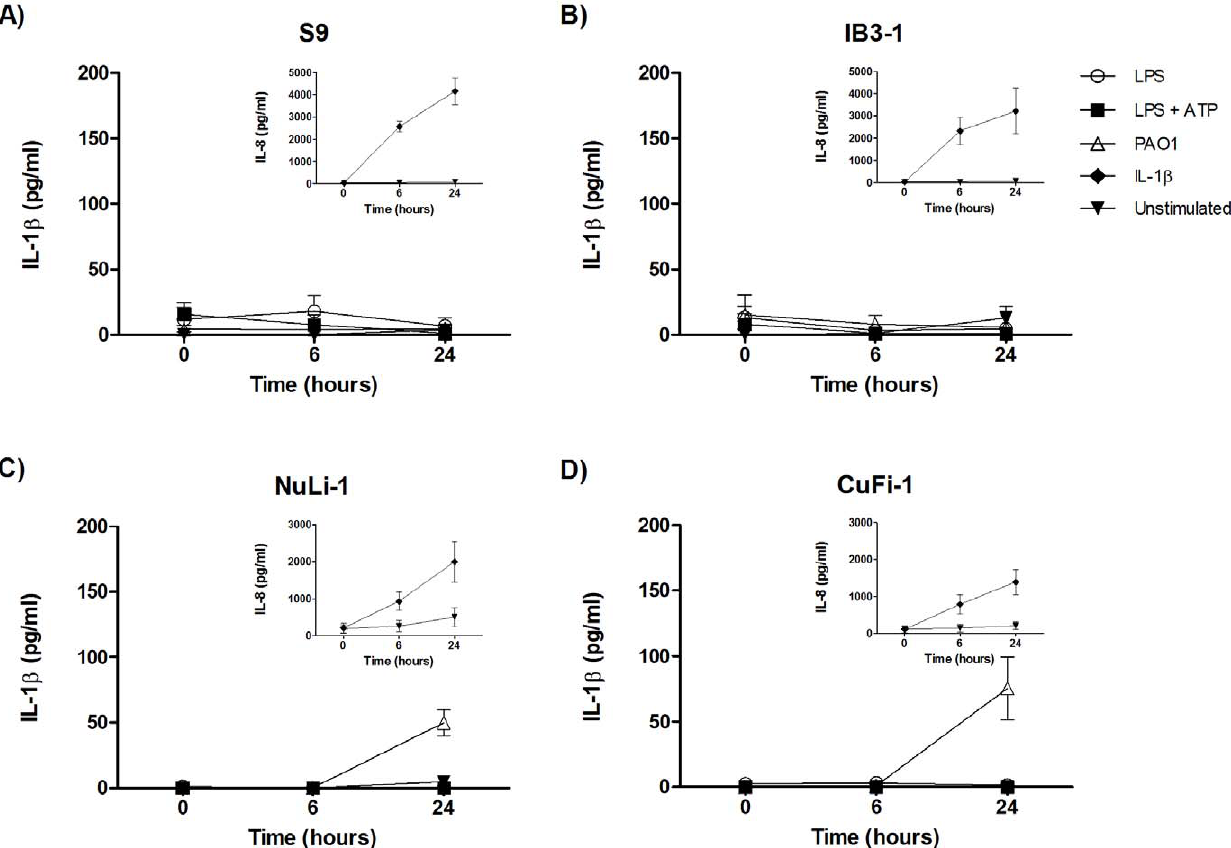
Figure 2. Airway epithelial cells do not significantly contribute to IL-1 b production in response to inflammasome stimuli. Control cell lines ((A) S9, (C) NuLi-1) and their corresponding CF cell lines ((B) IB3-1, and (D) CuFi-1) cells were stimulated with P. aeruginosa (MOI=10), ATP (5 mM), or IL-1 b (10 ng/ml), for the indicated times (n=3 individual experiments). Cells were primed with LPS (100 ng/ml) for 4 hours where appropriate. Cell culture supernatants were assayed for IL-1 b and IL-8 production by ELISA. Insert shows IL-8 secretion in response to stimulation with IL-1 b (10 ng/ml).